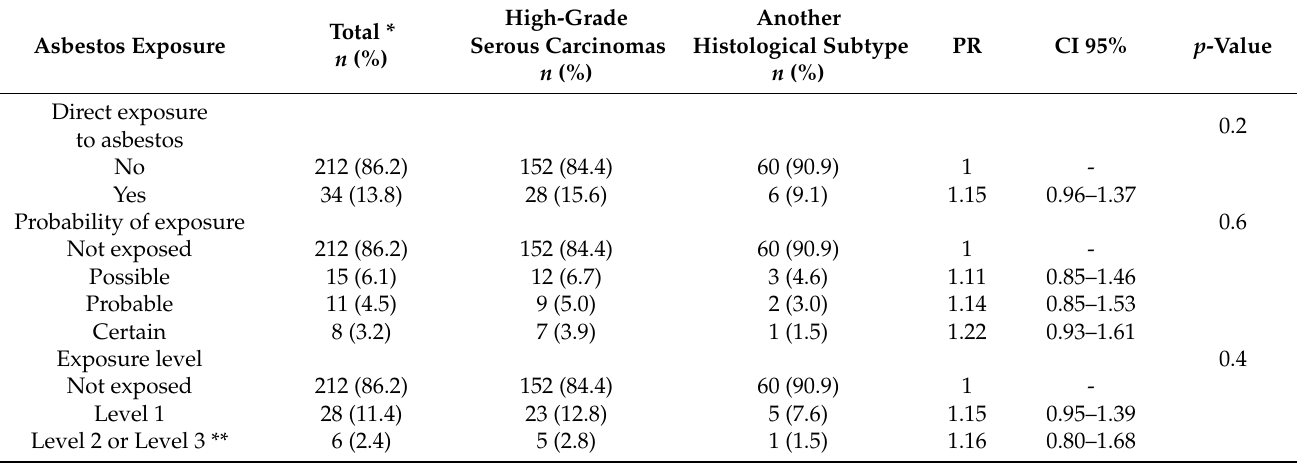
Table 6. Asbestos exposure and histological subtype, univariate analysis ( N =